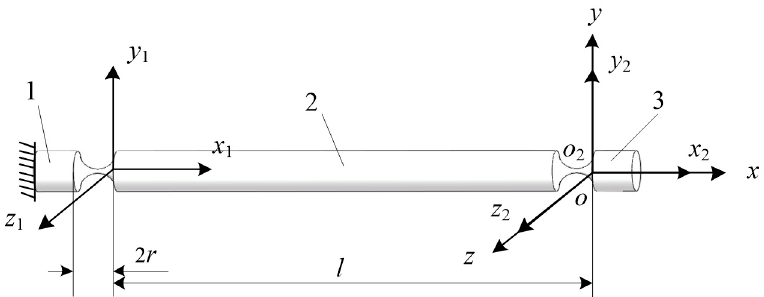
Figure 2. A serial chain of two RCCS compliant spherical joints.